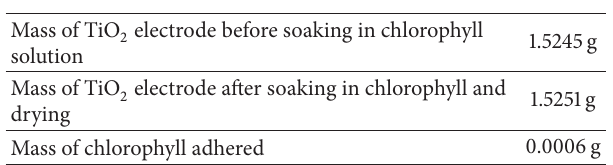
Figure 3: The log conductivity for PVA single and double salt varied temperature (298 K–373 K).